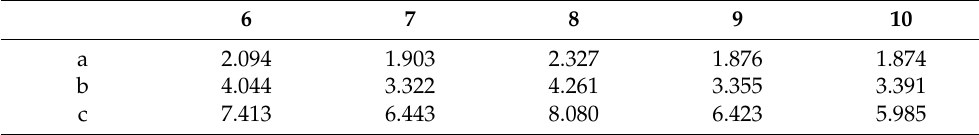
Table 4. The delivery airflow uniformity experiment of right five tubes. unit: